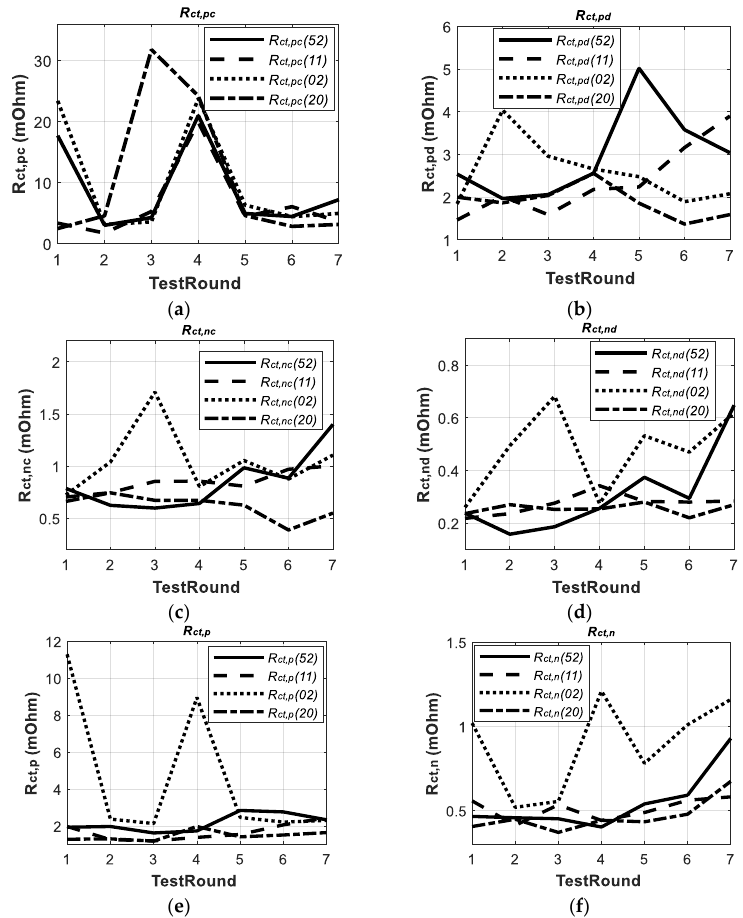
Figure 14. Elements values in linear circuits fitting for EIS: ( a ) R ct,pc ; ( b ) R ct,pd ; ( c ) R ct,nc ; and ( d ) R ct,nd in FPLC ACequ ; ( e ) R ct , p ; and ( f ) R ct , n in BHLC ACequ